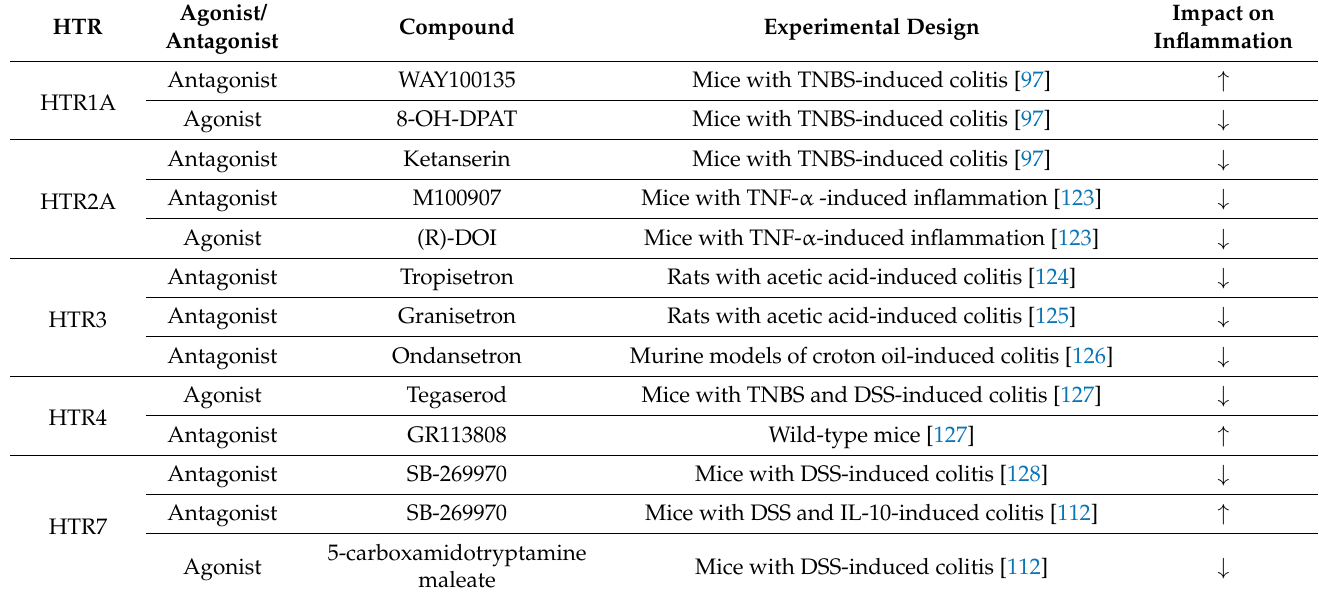
Table 6. Impact of 5-HT signaling on gut inflammation in animal IBD